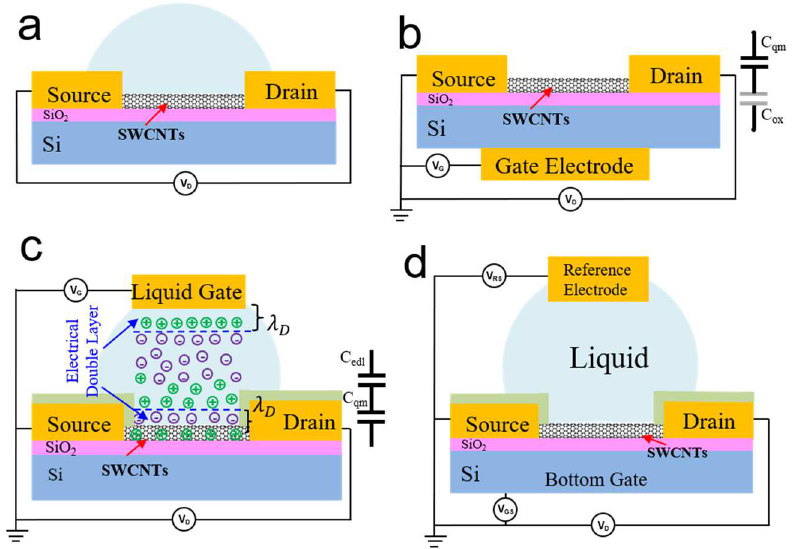
Figure 6. Three device structures of Bio–CNTFET. ( a ) Two-Electrode sensor. ( b ) Back-gate control device structure. ( c ) Electrolyte-gated control device structure. The electric double layer at the CNT–liquid interface acts as a gate insulator. A reference electrode, such as a Ag/AgCl wire, is used as the gate electrode. The electrical double layer at the CNT–liquid and liquid–gate interfaces is the source of geometric capacitance (C ox ). The quantum capacitance (C qm ) and geometric capacitance of carbon nanotubes constitute an in-series relationship. ( d ) Electrolyte trench isolation type.